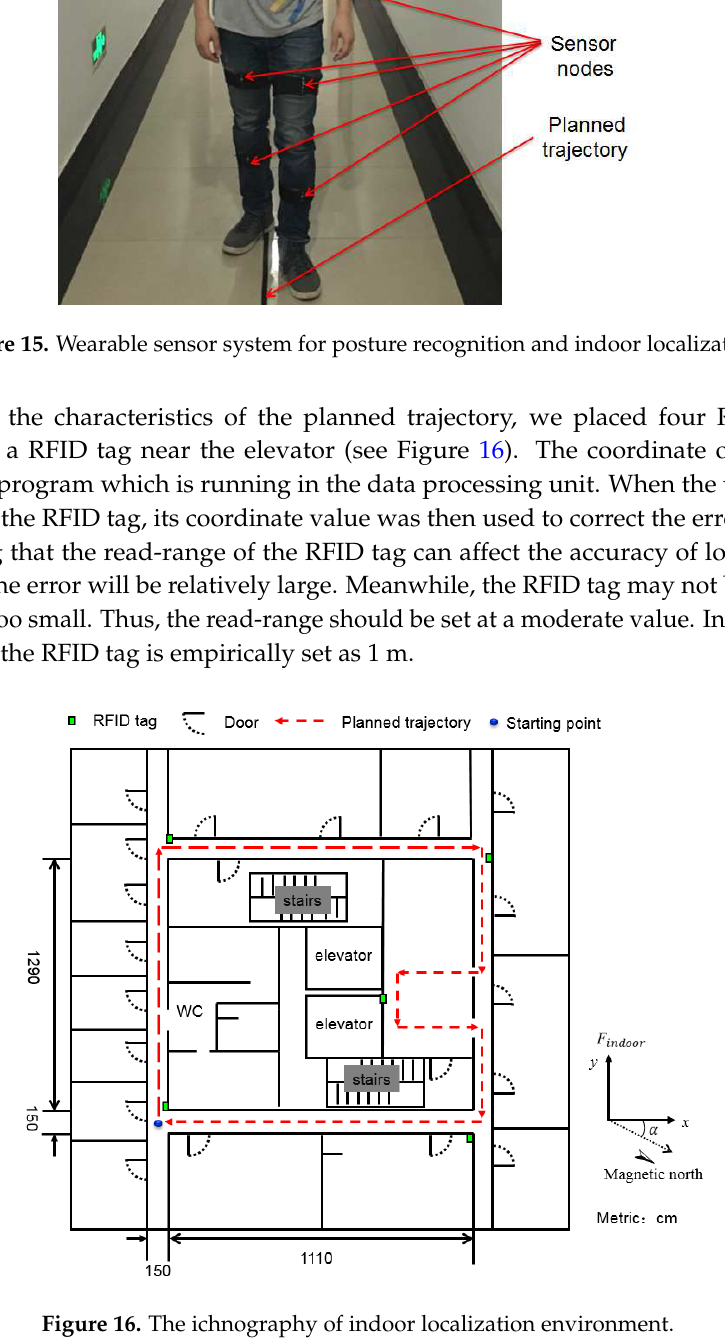
Figure 16. The ichnography of indoor localization